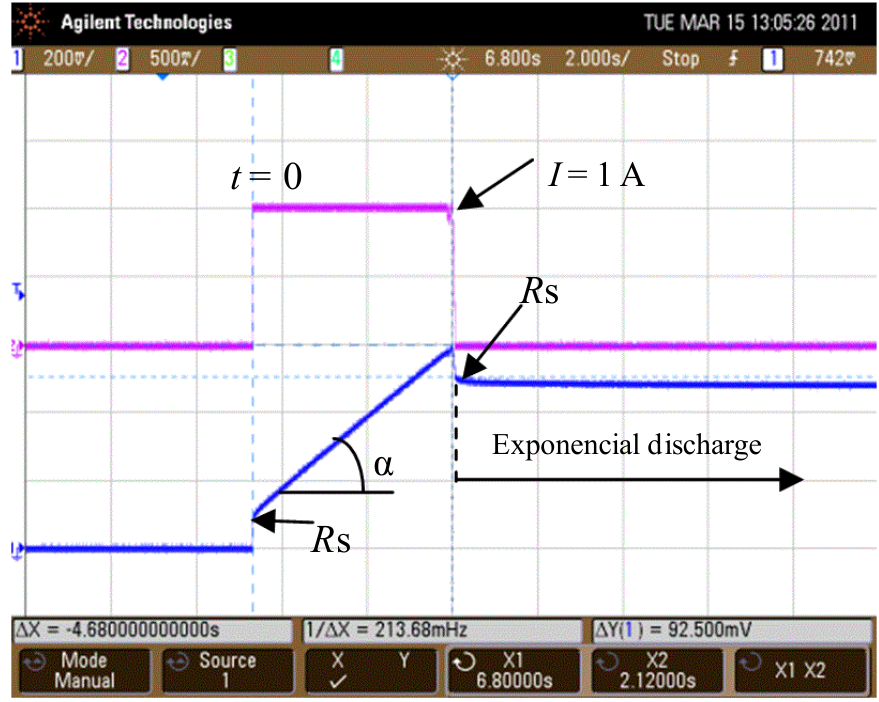
Figure 4. Electric charge/discharge test used for the parasitic determination. Top: Current source used, I ; Bottom: Voltage across the capacitor, V